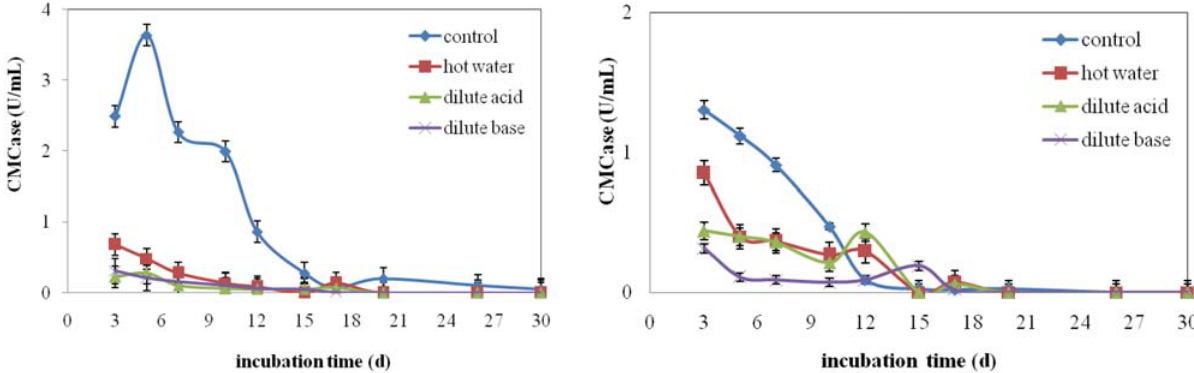
Figure 1. Variations of CMCase activities depending on peach (left side) and cherry (right side) cultures. The values are the mean ± SD for experi- ments of three separate